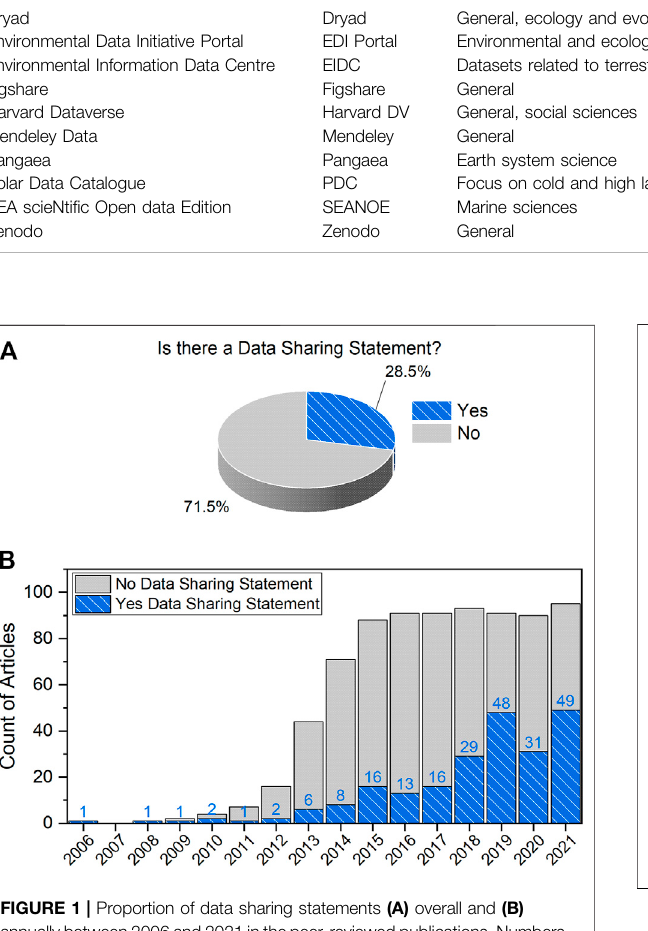
Frontiers in Environmental Science |